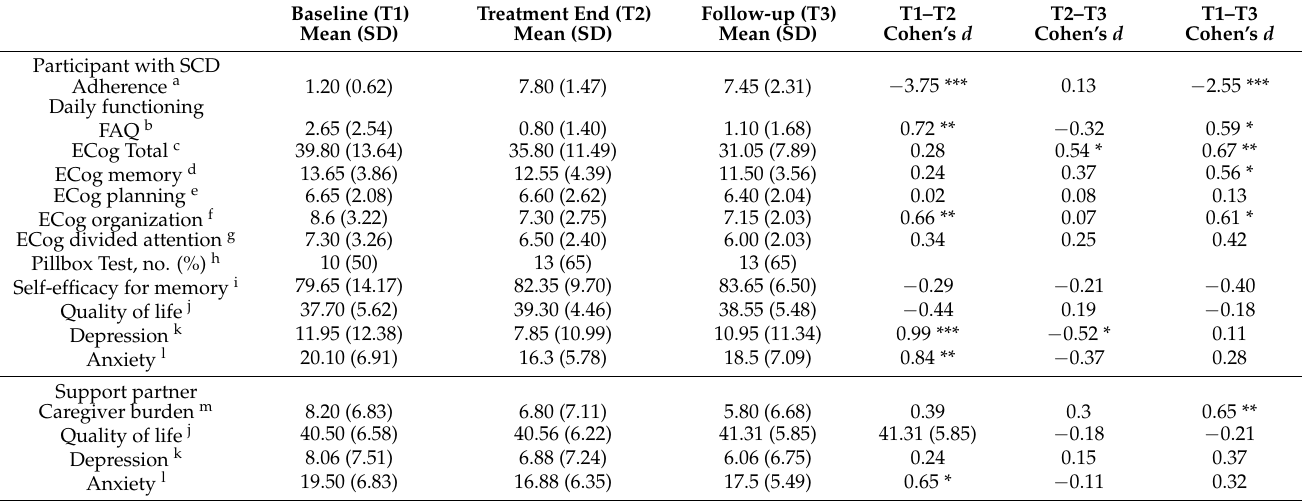
Table 2. Outcome variables for participants with SCD and their support